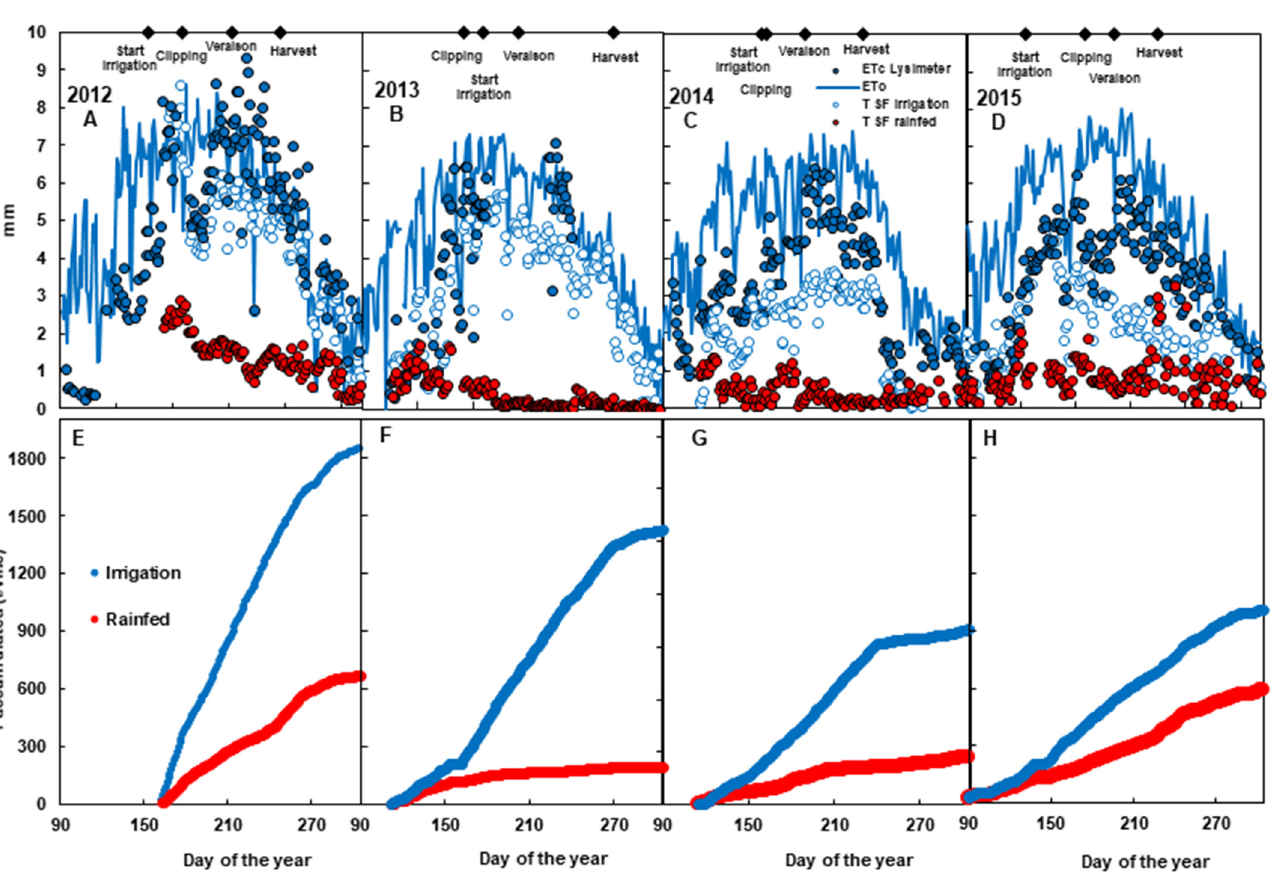
Figure 5. Seasonal evolution of crop evapotranspiration obtained with lysimetry (ET cLys ), reference evapotranspiration (ET o ), transpiration obtained by sap flow sensors (T SF ) for lysimeter and rainfed plants (graphs ( A – D )). Accumulative transpiration in the two treatments (Irrigation and Rainfed) and accumulative crop evapotranspiration (ET c ) during the years under study (2012, 2013, 2014 and 2015) (graphs ( E – H )). Each transpiration point is the average of the four sap flow sensors in the rainfed treatment, while in the irrigated treatment it corresponds to the two sensors located in each of the lysimeter vines.